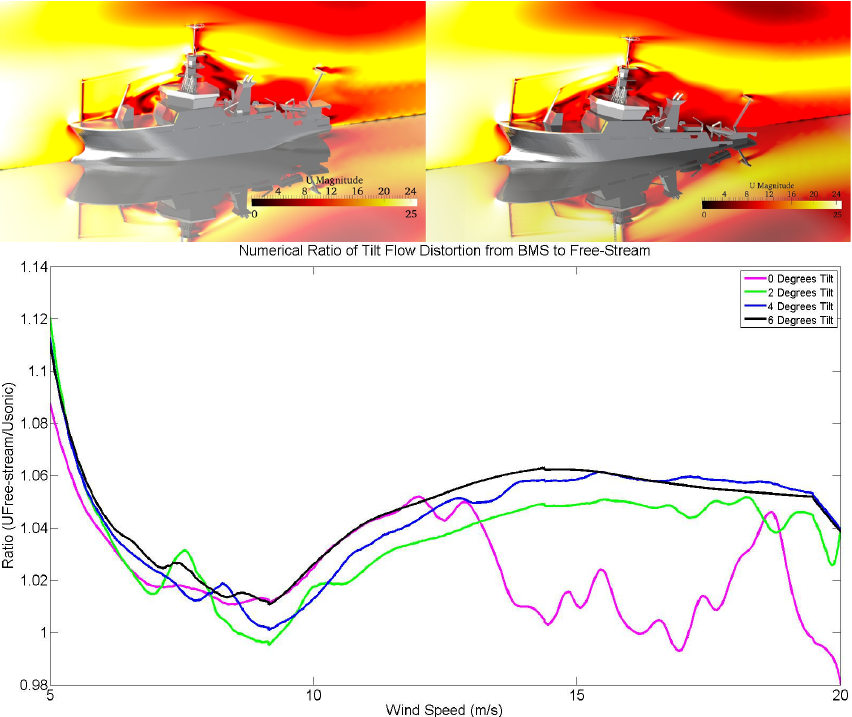
Fig. 10. (a) Flow speed over the ship for 0 ◦ and + 6 ◦ tilt for a steady-state input stream of 25ms − 1 . (b) Modelled ratio from BMS to undisturbed flow over 5 to 25ms − 1 for tilt angles of 0 ◦ , 2 ◦ , 4 ◦ and 6 ◦